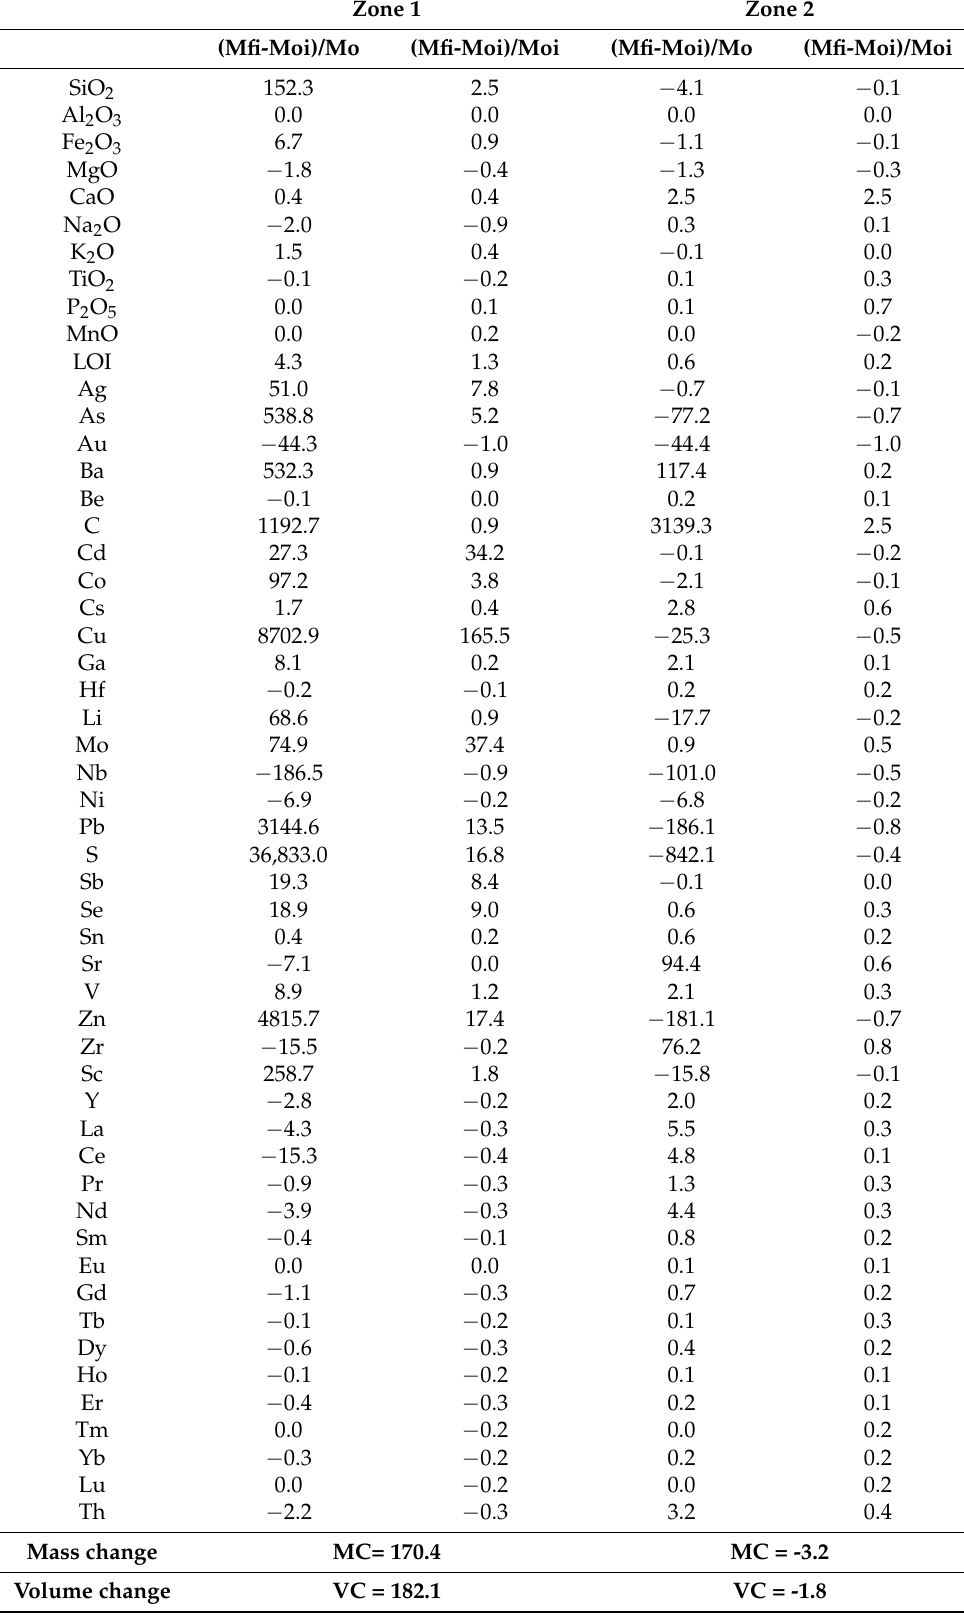
Table 3. Element/oxide mass changes in relation to the original whole-rock mass ((Mfi-Moi)/Mo) and in relation to the original element/oxide mass in the original rock